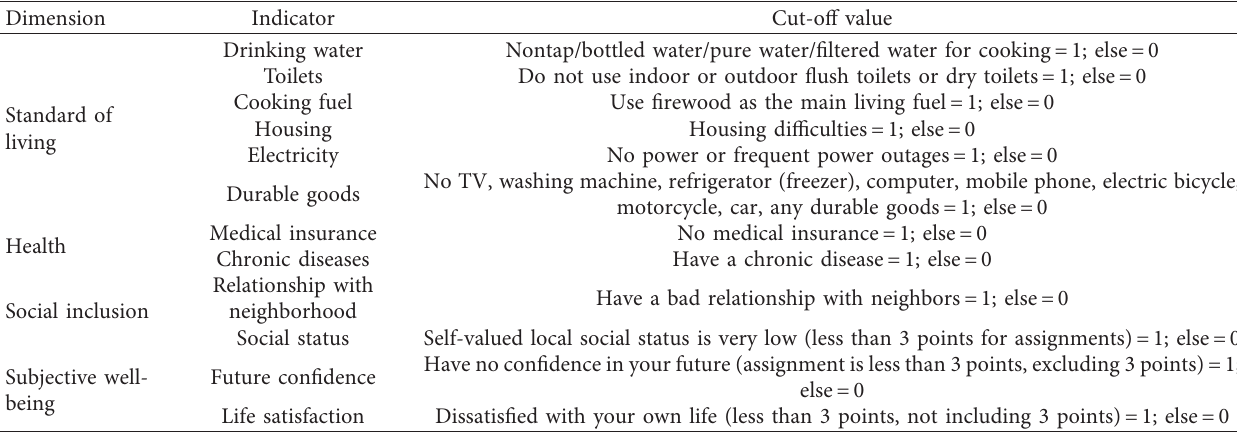
Table 1: Construction of the multidimensional poverty